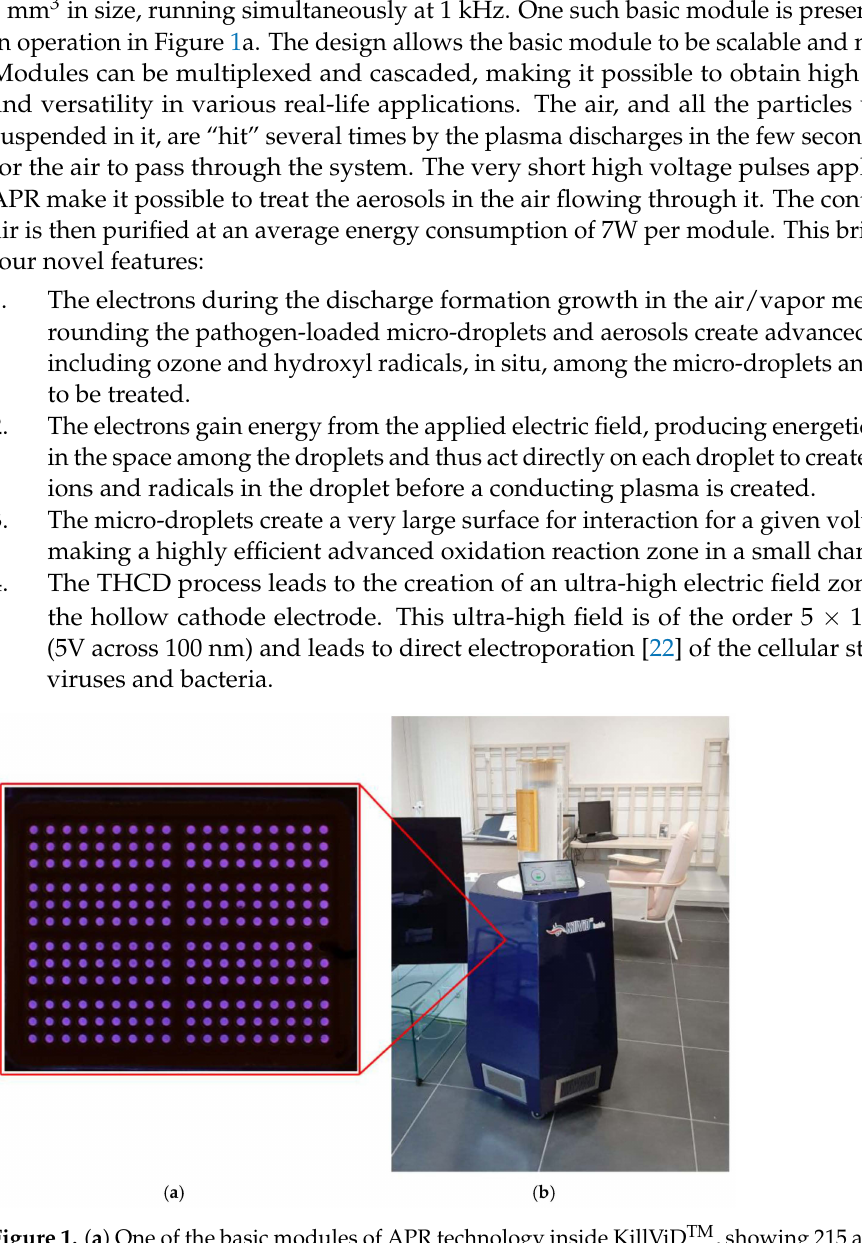
Figure 1. ( a ) One of the basic modules of APR technology inside KillViD TM , showing 215 atmospheric micro-plasma reactors functioning simultaneously. ( b ) KillViD TM air cleaner validation prototype based on the APR